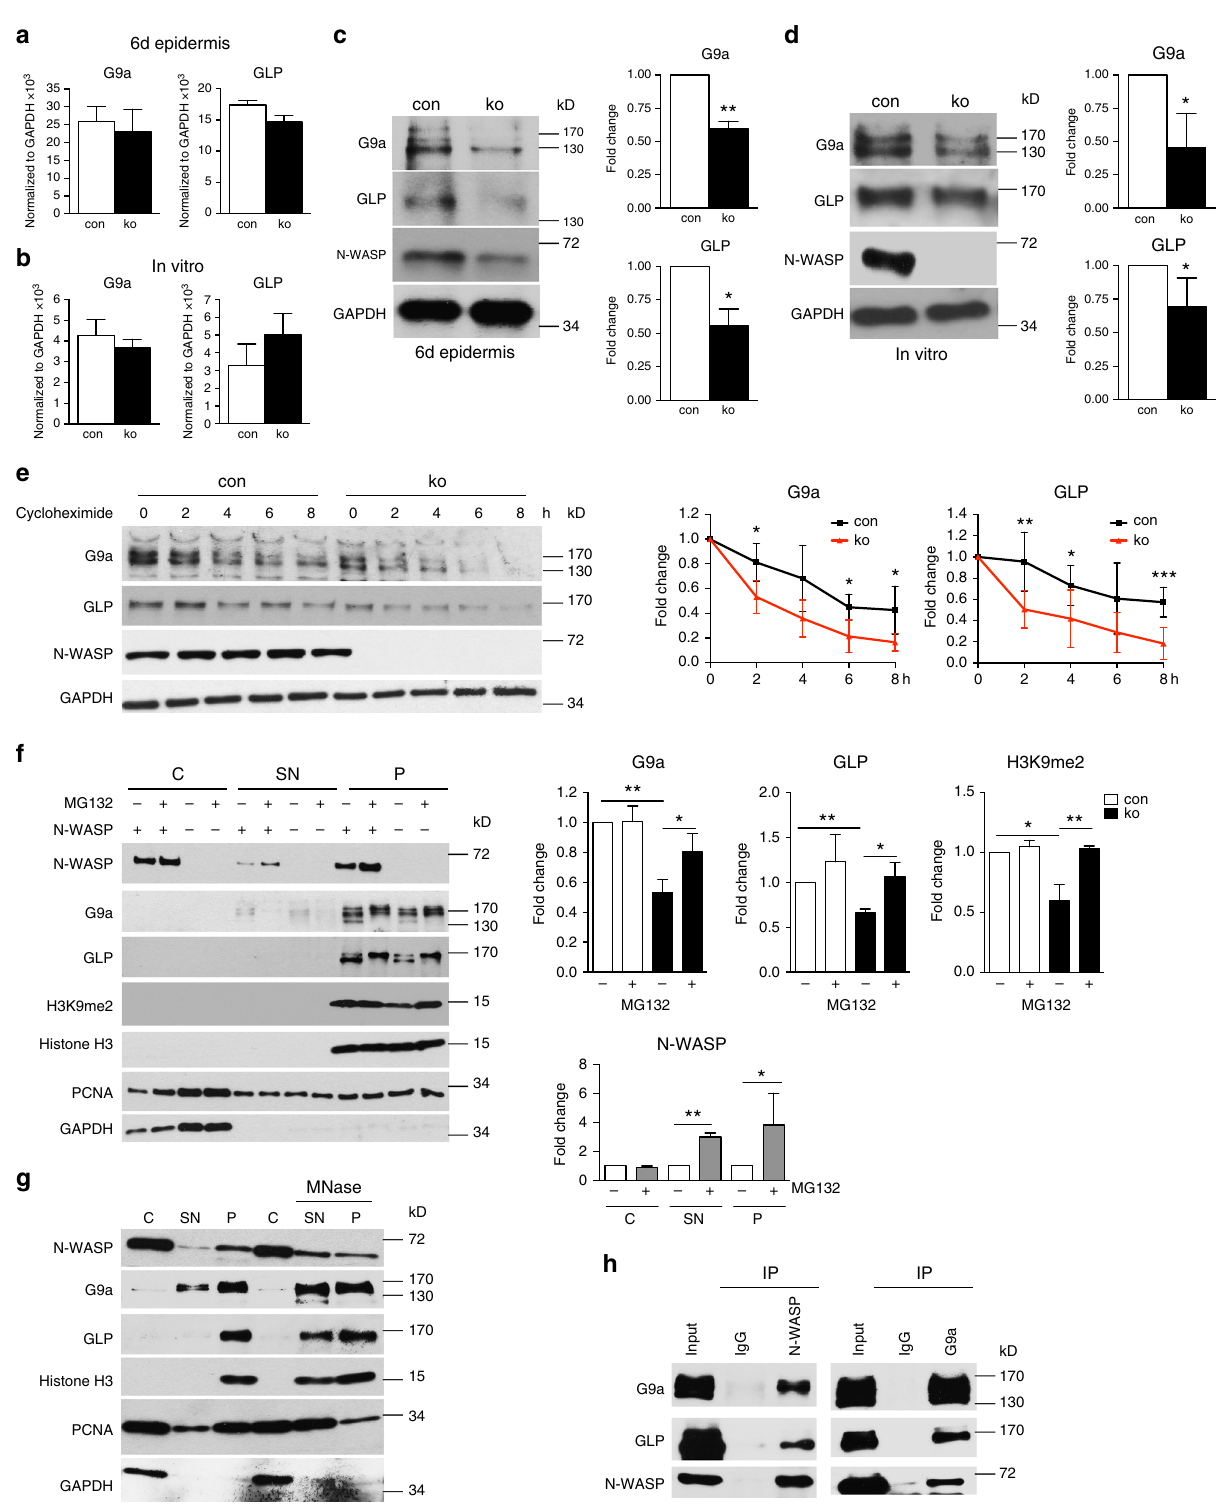
Fig. 8 N-WASP co-precipitates with and regulates the stability of the H3K9 methyltransferases G9a and GLP. Expression of G9a and GLP mRNA ( a , b ) and protein ( c , d ) in epidermis of 6-day-old mice ( a , c ) and in primary keratinocytes ( b , d ). ( n ( a , b , c ): 3/3; n ( d ): 5/5). e immunoblot analysis of protein stability of G9a and GLP in primary keratinocytes in the presence of cycloheximide (G9a n : 4/4, GLP n : 6/6, mean ± SD, two-tailed unpaired t -test). f Cell fractionation of keratinocytes after 90 min of treatment with the proteasome inhibitor MG-132 followed by immunoblot for indicated proteins, the indicated protein levels were quanti fi ed on the right ( n : 3/3, mean ± SD, two-tailed unpaired t -test). g Cell fractionation of primary keratinocytes with treatment of the pellet fraction with micrococcal nuclease followed by immunoblot for indicated proteins (MNase) ( n : 3). h Co-precipitation of N-WASP with G9a and GLP in primary keratinocyte nuclear lysates ( n : 3). C: cytosolic fraction, SN: soluble nuclear fraction, P: pallet (* p ≤ 0.05; ** p ≤ 0.01; *** p ≤